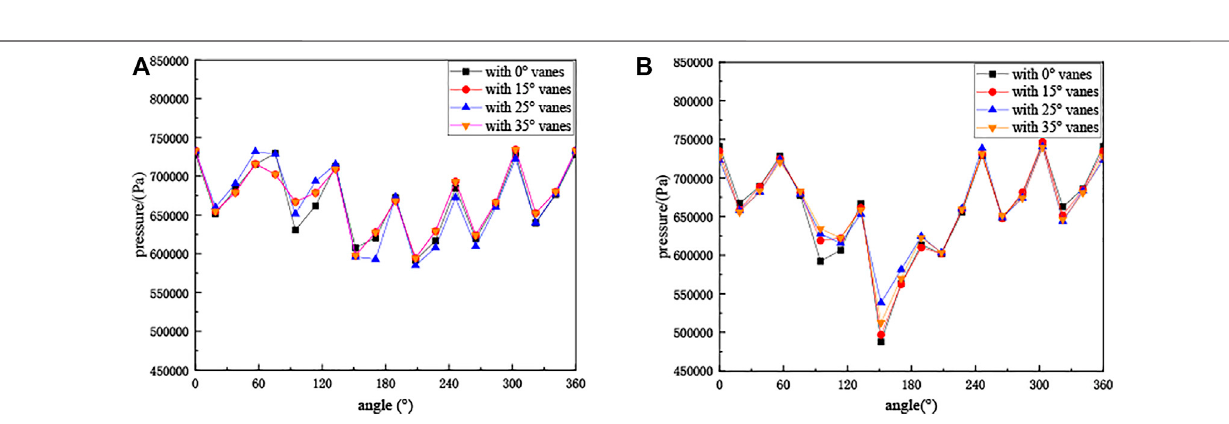
Frontiers in Energy Research |